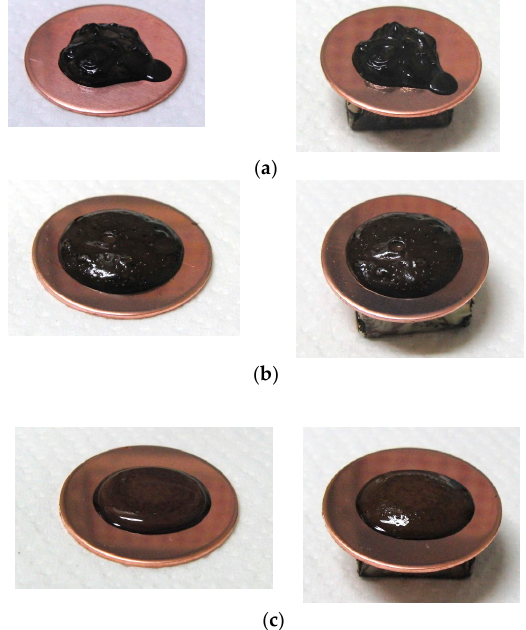
Figure 2. Photographs of MCF rubber Types 6–8 with Al 2 O 3 dielectric particles before electrolytic polymerization, without the application of a magnetic field (left column) and with application (right column): ( a ) Type 6; ( b ) Type 7; ( c ) Type 8.